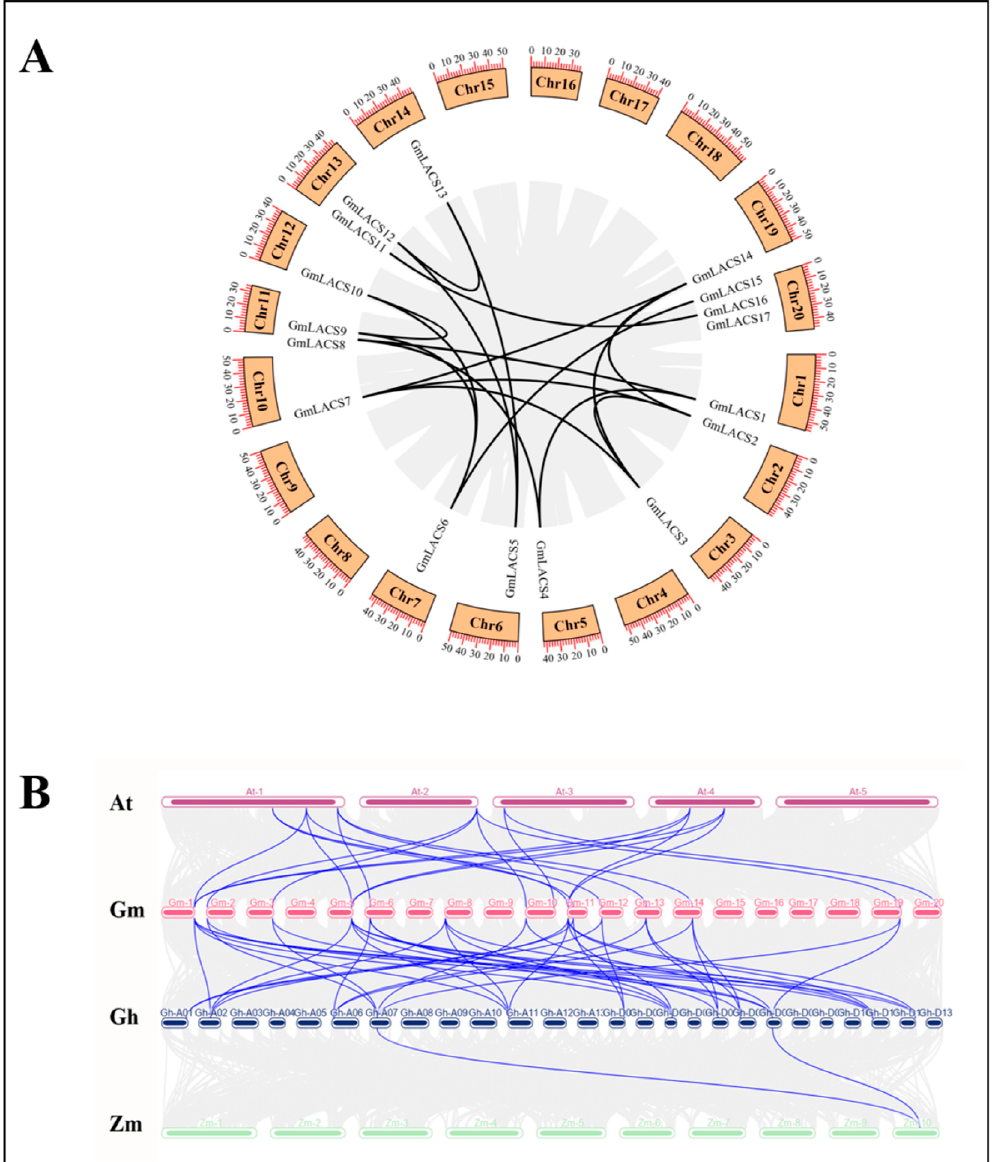
Figure 3. Collinearity analysis of genes in GmLACS family. ( A ) Collinearity analysis of 17 GmLACS genes. The soybean chromosome is shown as an orange arc, the red scale shows chromosome length in Mb, the black highlighted curve shows the GmLACS collinearity region, and the gray curve shows the genome-wide collinearity of soybean. ( B ) Collinearity analysis of GmLACS , AtLACS , GhLACS and ZmLACS . From top to bottom, the chromosomes of these species are Arabidopsis, soybean, upland cotton, and maize. The blue highlighted curve represents the collinearity region of LACS , and the gray curve represents the genome-wide collinearity of the above-mentioned species.